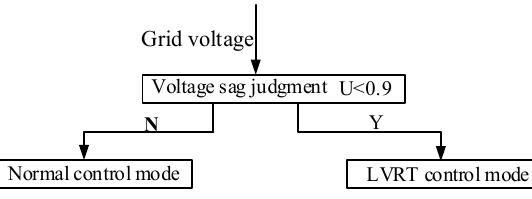
Figure 2. Control switching flow chart of inverter.